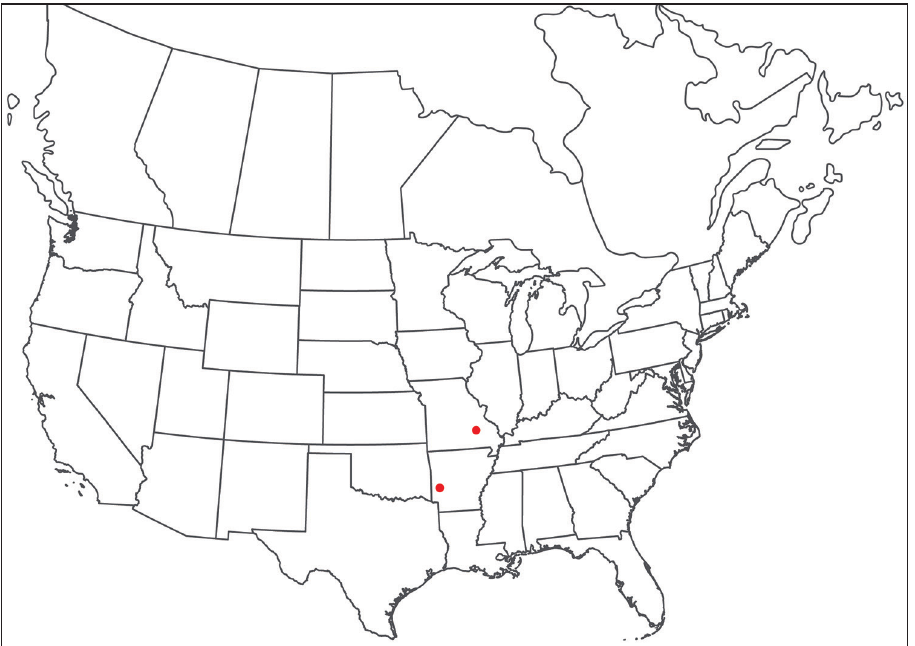
Figure 24. Torrenticola biscutella sp. n.